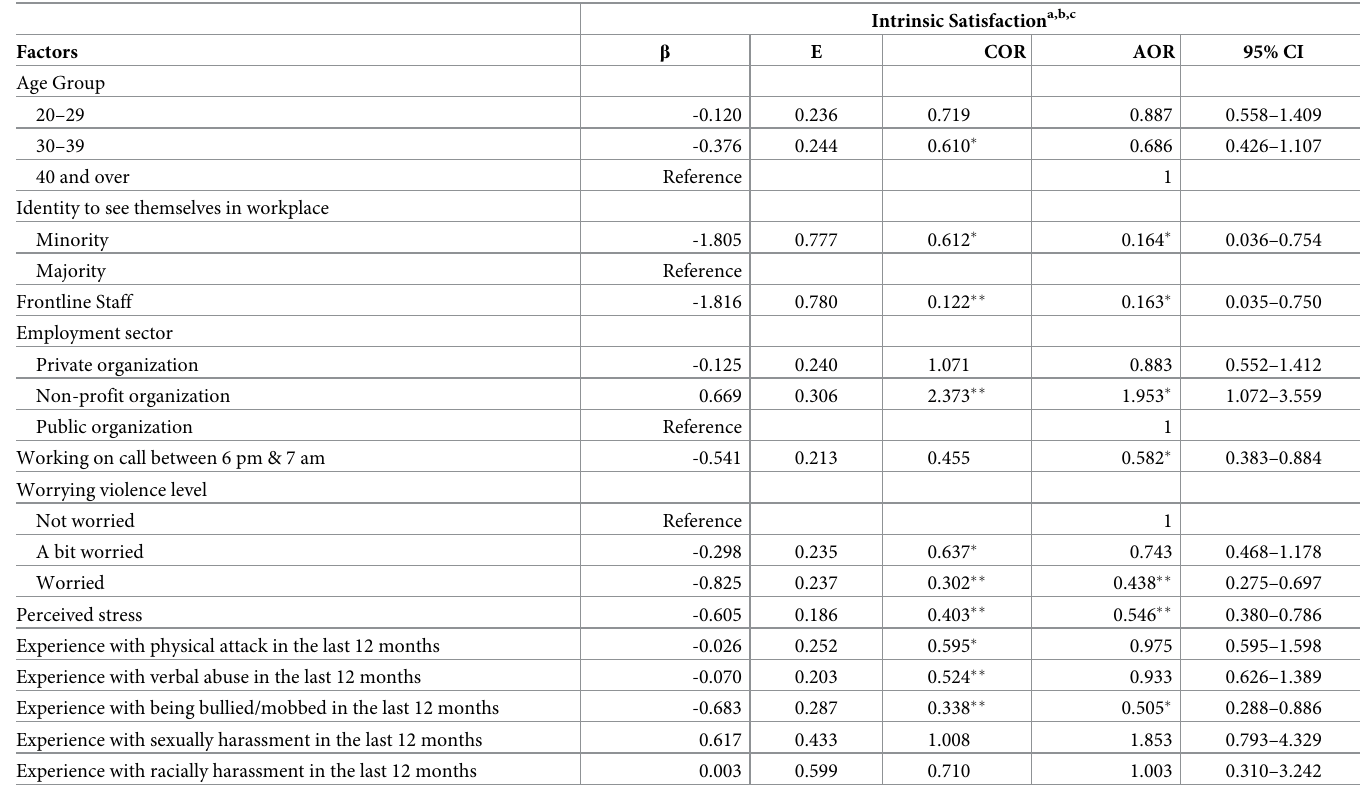
Table 7. Association between risk factors and intrinsic job